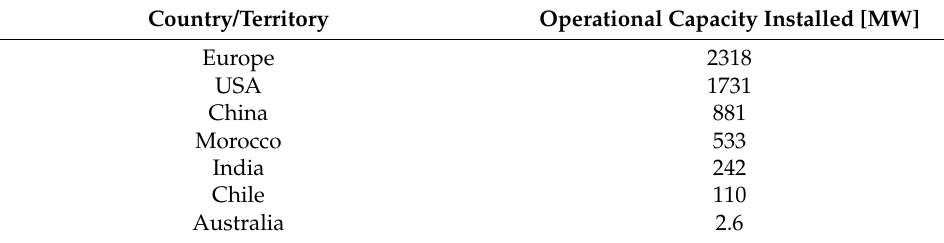
Table 1. Operational capacity of CSP installed in different countries/territories [16].